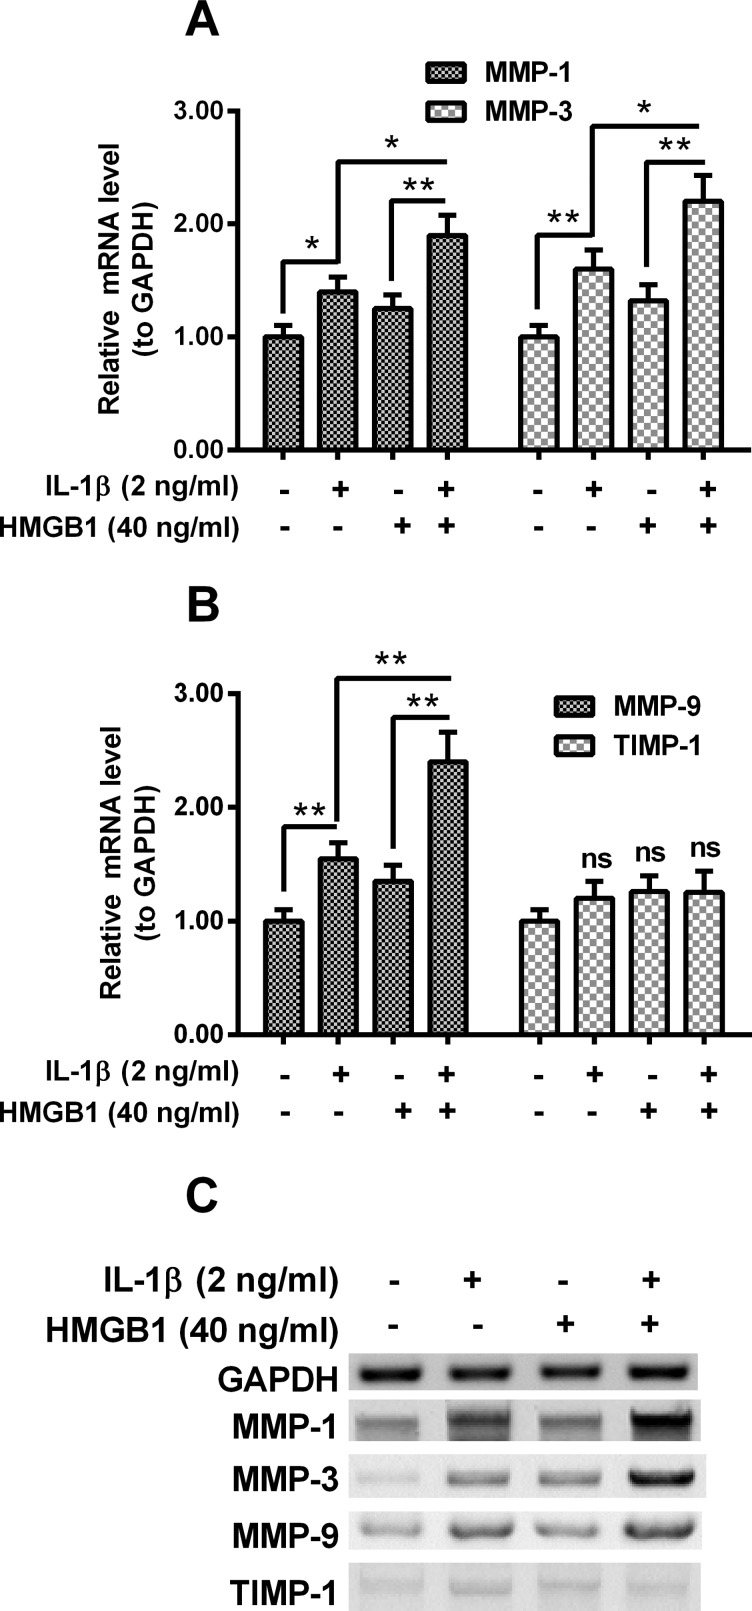
Expression of MMPs in the IL-1β- or/and HMGB1-treated disc annulus fibrosus cellsDisc annulus fibrosus cells were treated with 2 ng/ml IL-1β or (and) with 40 ng/ml HMGB1 for 12 h, then the relative mRNA levels of MMP-1 (A), -3 (A), -9 (B) or TIMP metallopeptidase inhibitor 1 (TIMP-1) (B) to Glyceraldehyde 3-phosphate dehydrogenase (GAPDH) were examined with real-time quantitative PCR (RT-qPCR) method; (C) western blotting assay for MMP-1, -3, -9 and TIMP-1 in protein levels in the IL-1β- or (and) HMGB1-treated disc annulus fibrosus cells. Results are presented as mean ± S.E.M. for quartic independent experiments. Parametric ANOVA (Tukey–Kramer post hoc) test was performed for statistical significance analysis. *P<0.05, **P<0.01 or ns: no significance.